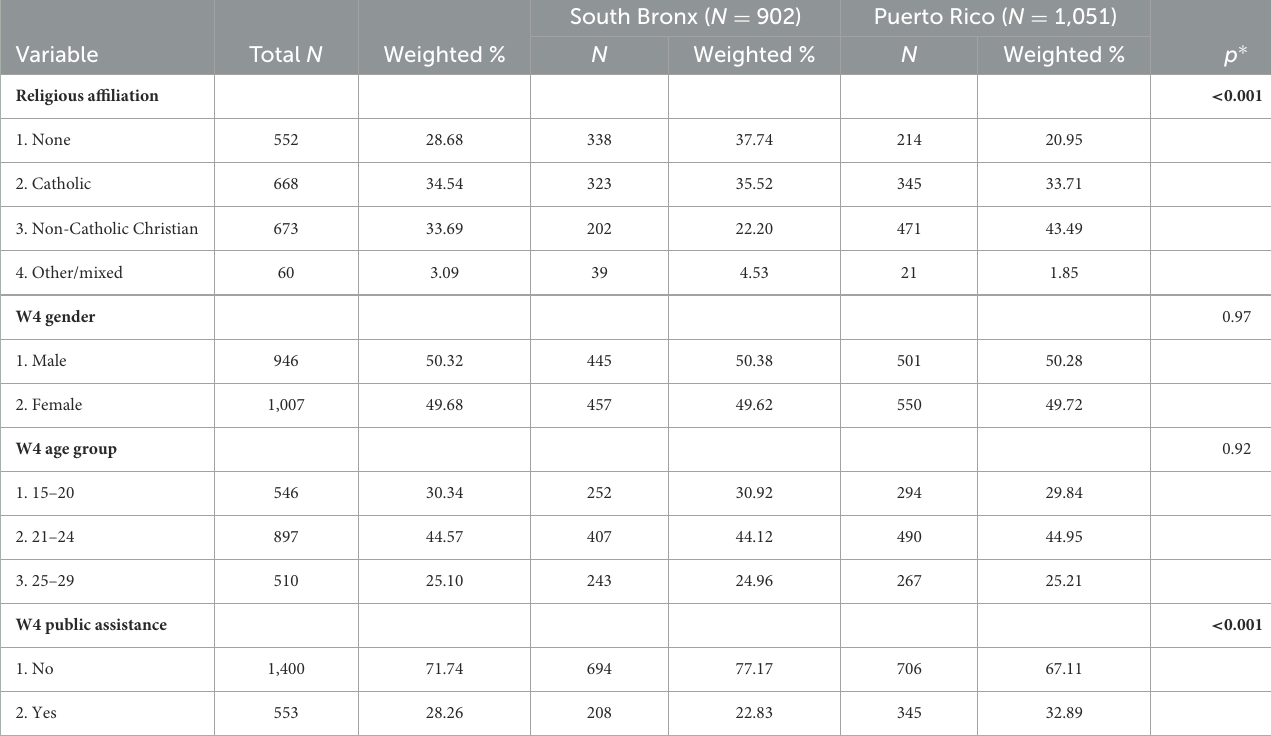
TABLE 1 Descriptive statistics, total, and by site.